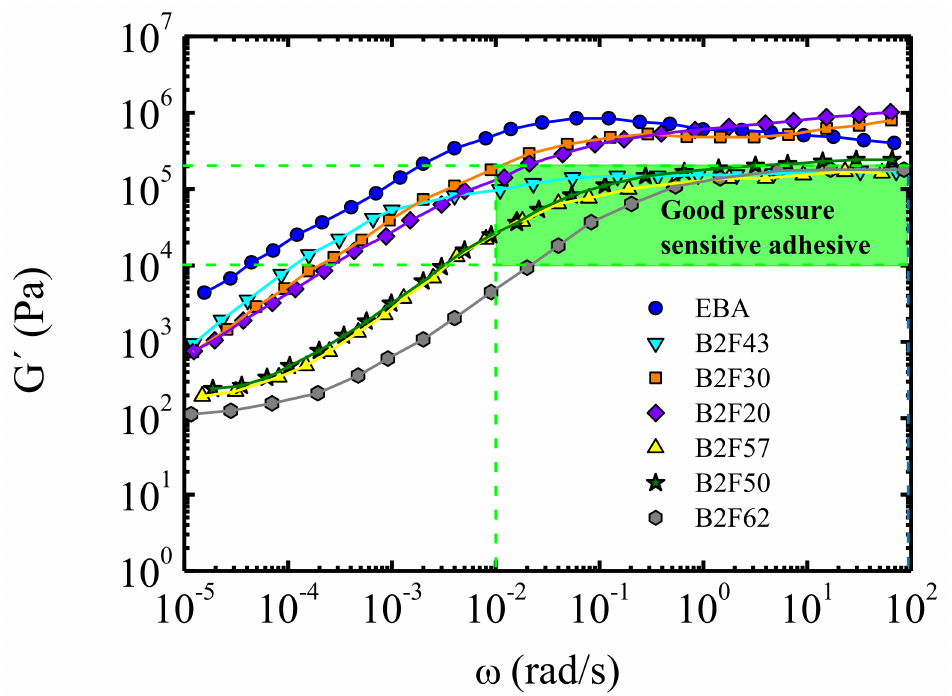
Figure 8. Storage modulus versus frequency for ethylene-co-n-butyl acrylate-based formulations; the number next to F indicates the amount of hydrogenated glycerol rosin ester in weight. As indicated, the square marks the quality of the pressure sensitive adhesive